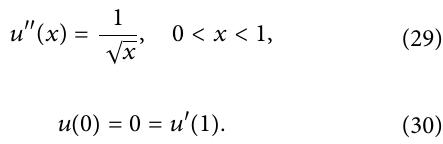
vs approximate solutions 𝑢(𝑥)